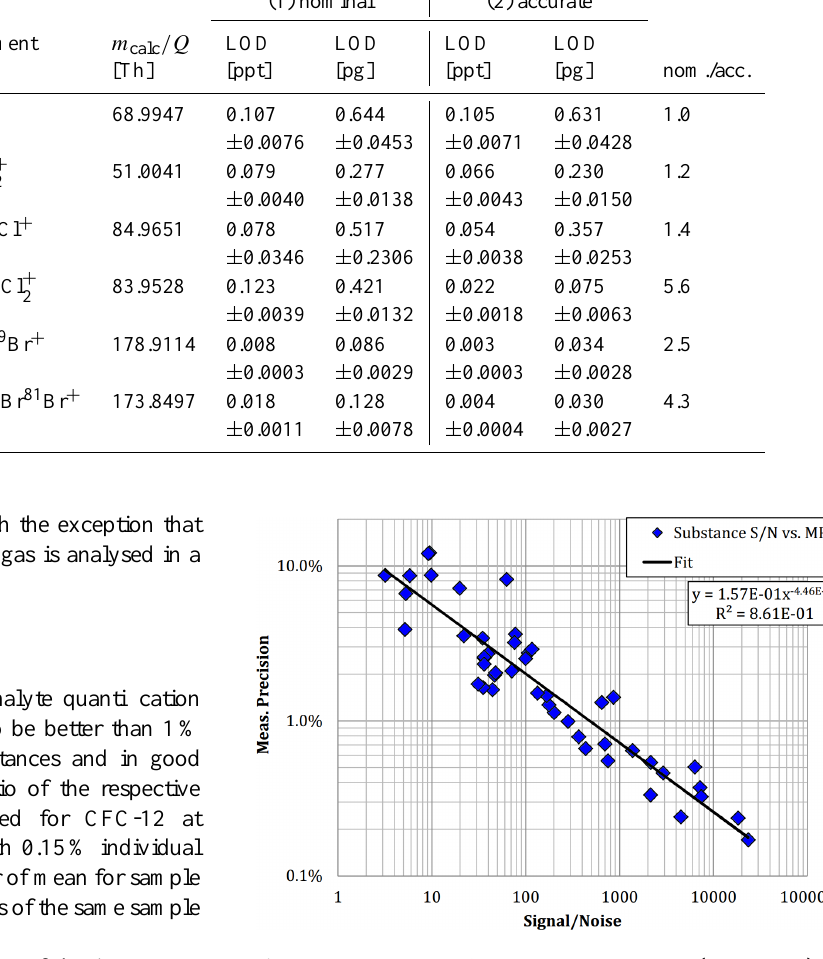
Figure 5. Correlation of measurement precision ( y axis, MP) and signal-to-noise ratio ( x axis) on a double-logarithmic plot. Data derived from repeated measurements of the same reference gas at constant sample volume of about 0.66L; evaluation based on nominal mass